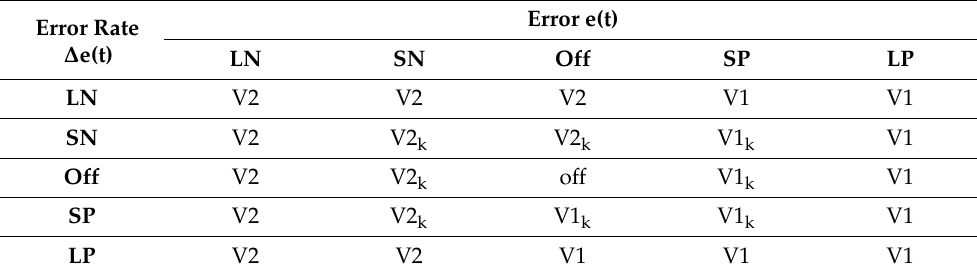
Figure 9. Inputs and output membership functions. Table 2. The suggested controller design’s fuzzy rule